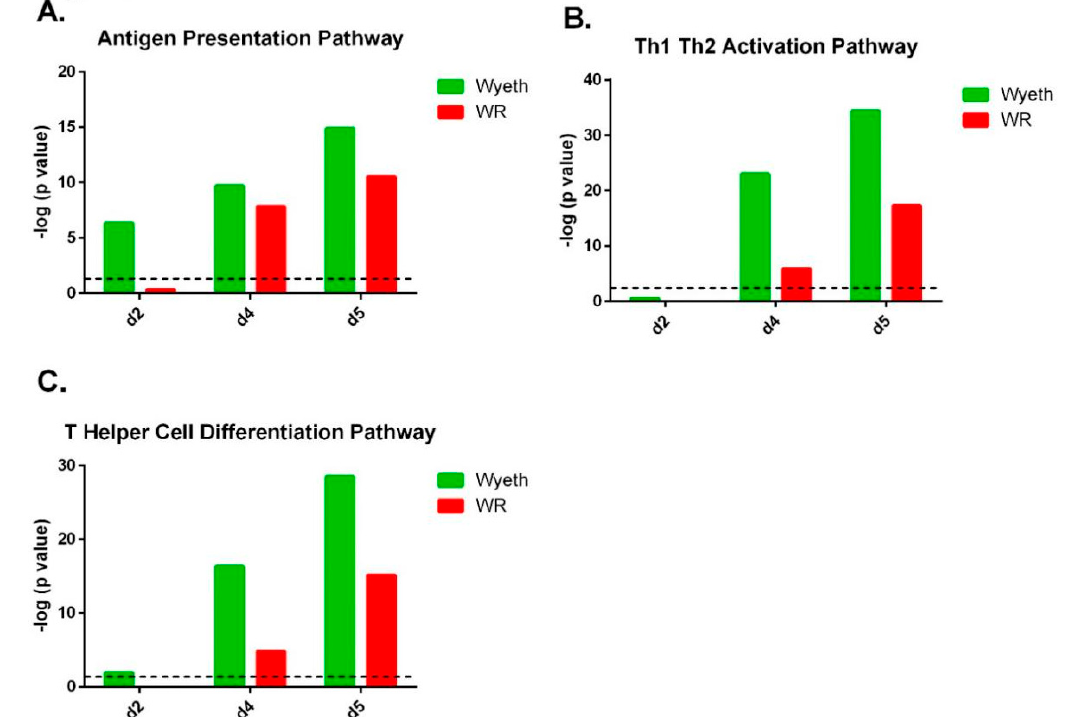
Figure 6. Clearance of VACV-Wyeth from infected brain is associated with robust induction of brain immunity pathways. Ingenuity pathway analysis (IPA) analysis based on brain gene expression of